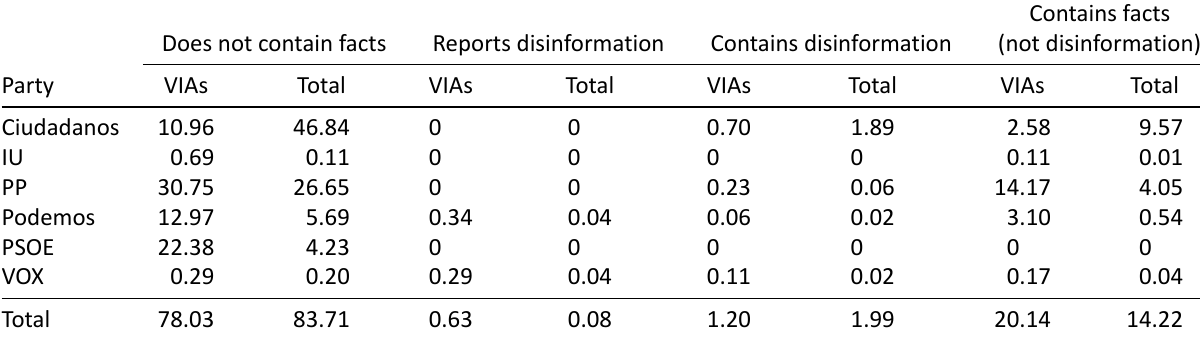
Table 3. Distribution of the disinformation variable by party (%).